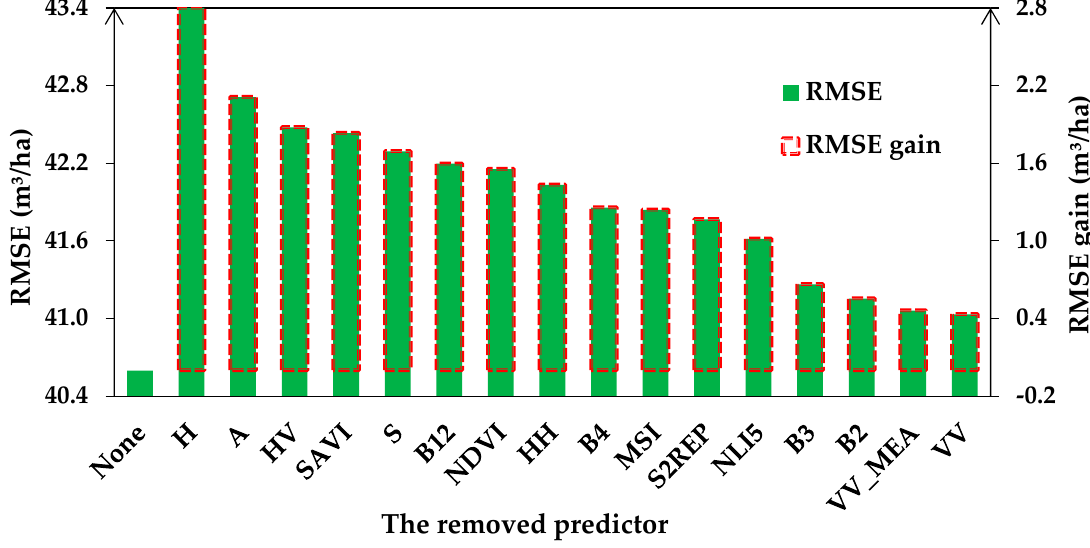
Figure 4. Variable importance shown by increase in the root mean square errors (RMSEs) of SVR models after excluding a predictor.